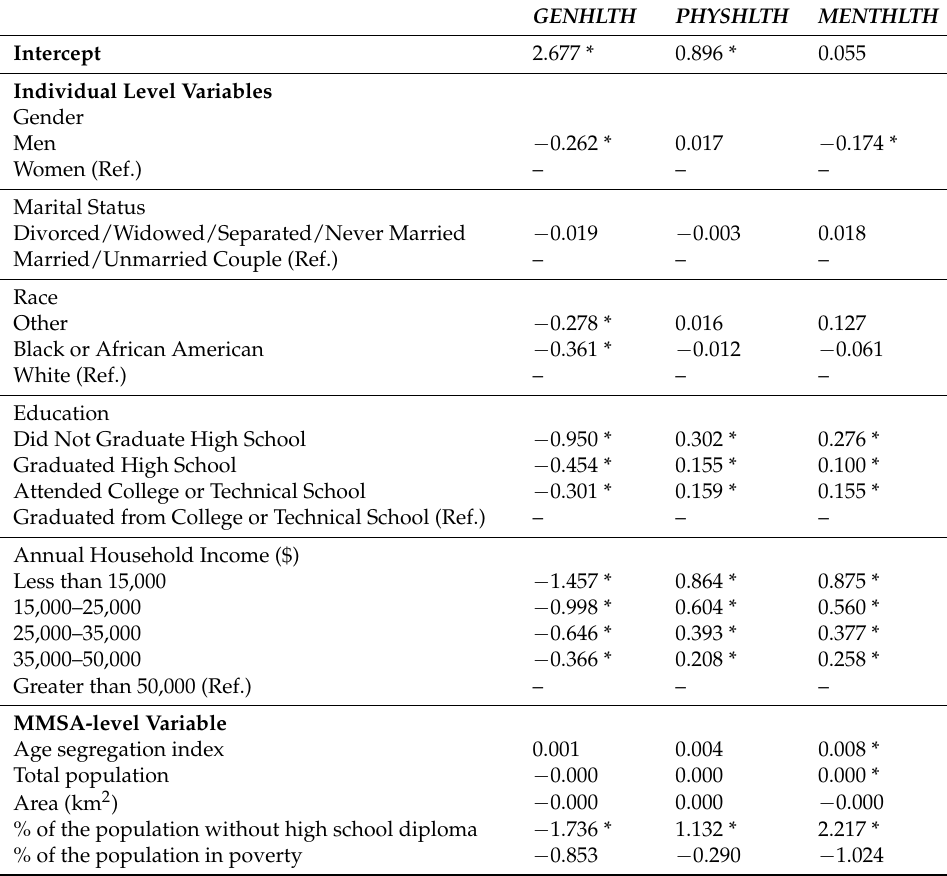
Table 4. Multilevel models (Model 4) predicting variation in the self-rated health of older adults among US cities (the age segregation index as a continuous